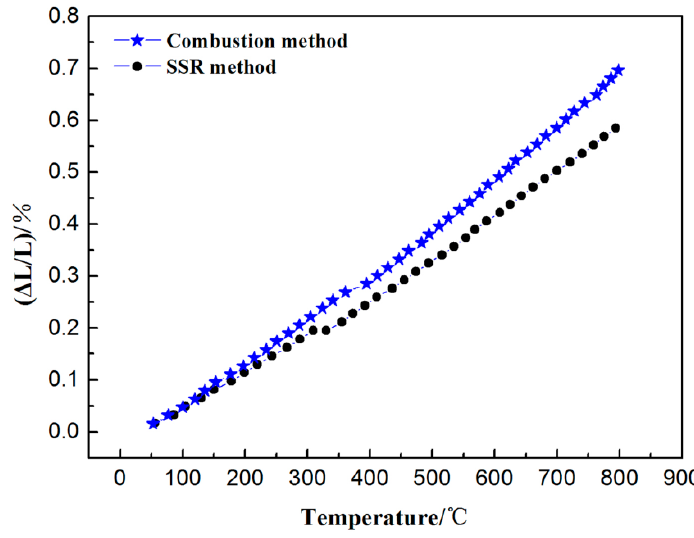
Figure5. ThermalexpansionbehaviorsofLa 0.8 Ca 0.2 CrO 3 ceramicssynthesizedbythedi ff Figure 5. Thermal expansion behaviors of La 0.8 Ca 0.2 CrO 3 ceramics synthesized by the different methods.